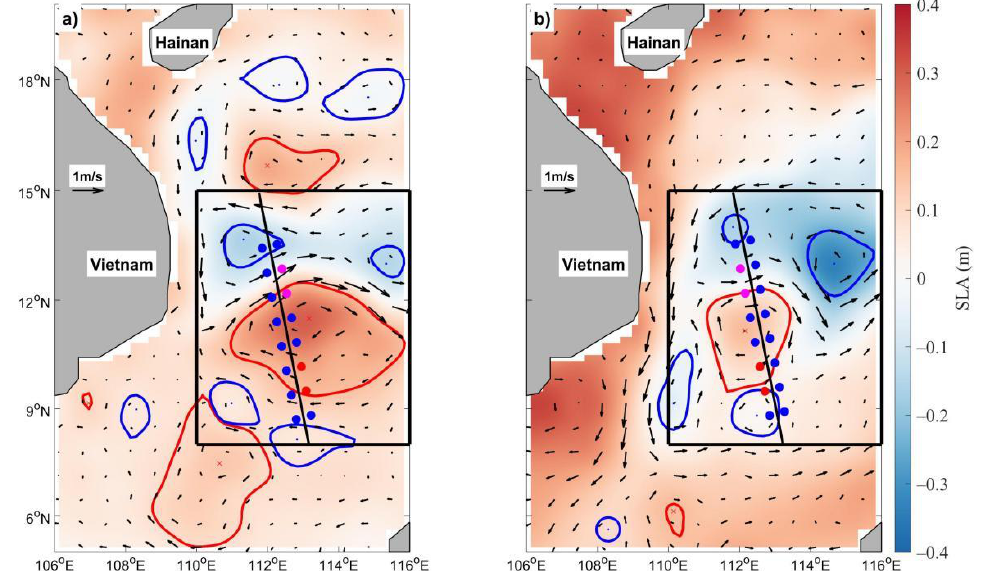
Figure 1. The current system and eddies in the SCS. The dots and black lines show CFOSAT-SWIM wave and wind track on ( a ) 8 October 2019, and ( b ) 16 November 2019. The shading color in the panels represent sea level anomaly (SLA). The black arrow represents AVISO geostrophic current anomaly. Red and blue lines demarcate warm- and cold-core eddies identified by the automatic eddy detection algorithm. In this study, attention is placed on the warm-core eddy in the black box (Section 4).